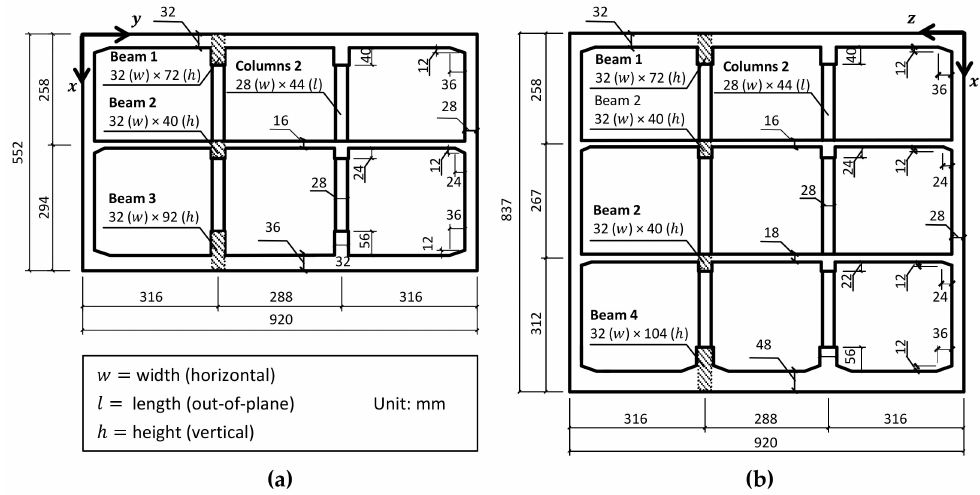
Figure 5. Cross-sections of ( a ) a two-story section and ( b ) a three-story section in